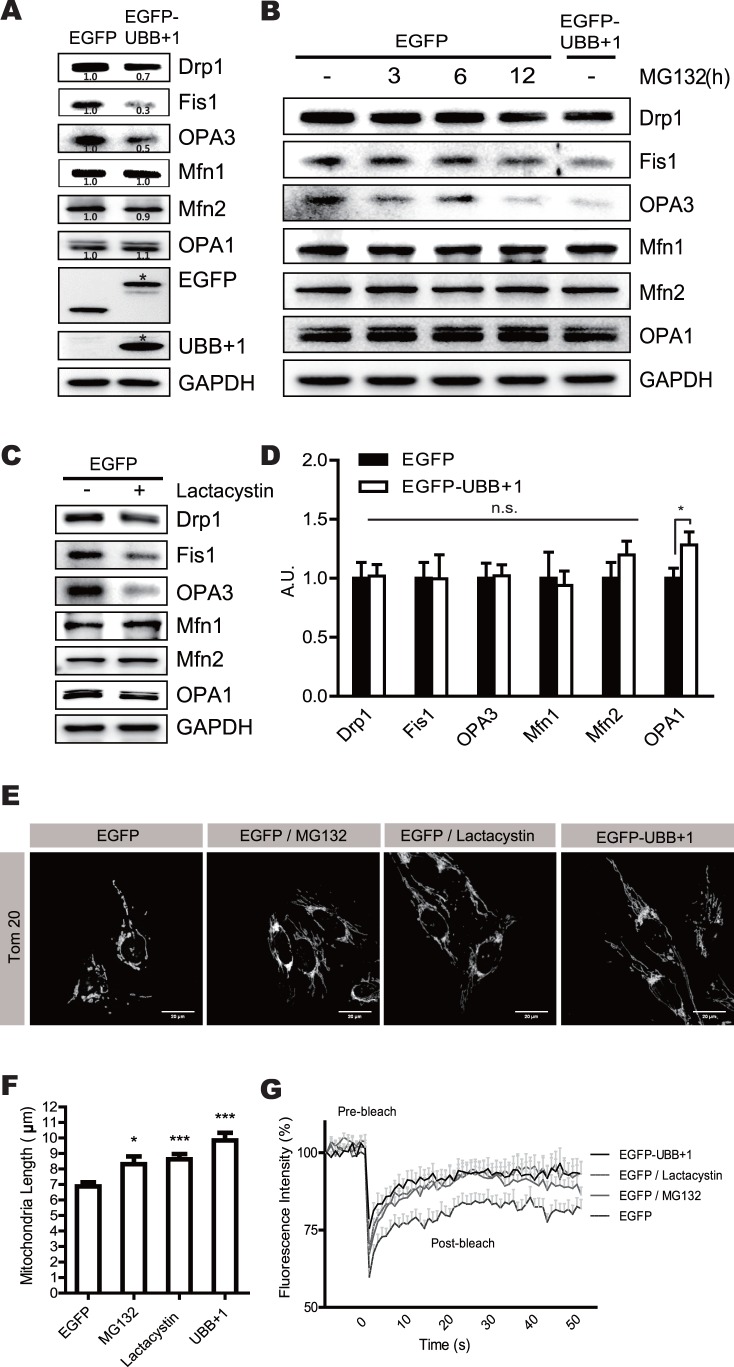
The regulation of mitochondrial dynamics by proteasome inhibition and ectopic expression of UBB+1 in CRT-MG human astrocytes.
A, CRT-MG cells stably transfected with pEGFP or pEGFP-UBB+1 were harvested. Western blotting was carried out with antibodies against mitochondrial fission-specific (Drp1, Fis1, and OPA3) and fusion-specific proteins (Mfn1, Mfn2, and OPA1). GAPDH was used as a loading control, and all blots are representative of three independent experiments. Below numbers indicates the result of densitometry quantification. B, C, Cells were incubated in the absence or presence of 1 µmol/L MG132, a reversible proteasome inhibitor for 0–12 h, or 1 µmol/L lactacystin, an irreversible proteasome inhibitor, for 12 h. Cell lysates were analyzed by Western blotting for mitochondrial proteins. D, mRNA levels of Drp1, Fis1, OPA3, Mfn1, Mfn2, and OPA1 were assessed by real-time PCR. Statistical analysis was performed using Tukey’s post hoc test. Asterisks indicate significant differences compared with the control; *p<0.05. E, Mitochondrial morphology was analyzed with Tom20 staining by confocal microscopy in CRT-MG cells stably expressing pEGFP or pEGFP-UBB+1 after treatment with MG132 or lactacystin for 12 h (scale bar = 20 µm). F, The average mitochondrial length in single cells was measured using ImageJ software. Data are presented as the mean ± SEM, n = 30 cells. Turkey’s post hoc test was applied to significant group effects identified using ANOVA (p<0.0001). Asterisks indicate a statistically significant difference compared with the control; *p<0.05, ***p<0.001. G, The fluorescence intensity recovery rates after photobleaching are plotted. Cells were transfected with Mito-DsRed and incubated in the presence of 0.5 µmol/L MG132 or lactacystin for 12 h. Data are plotted as the mean ± SEM (n = 15–20 cells for each group).